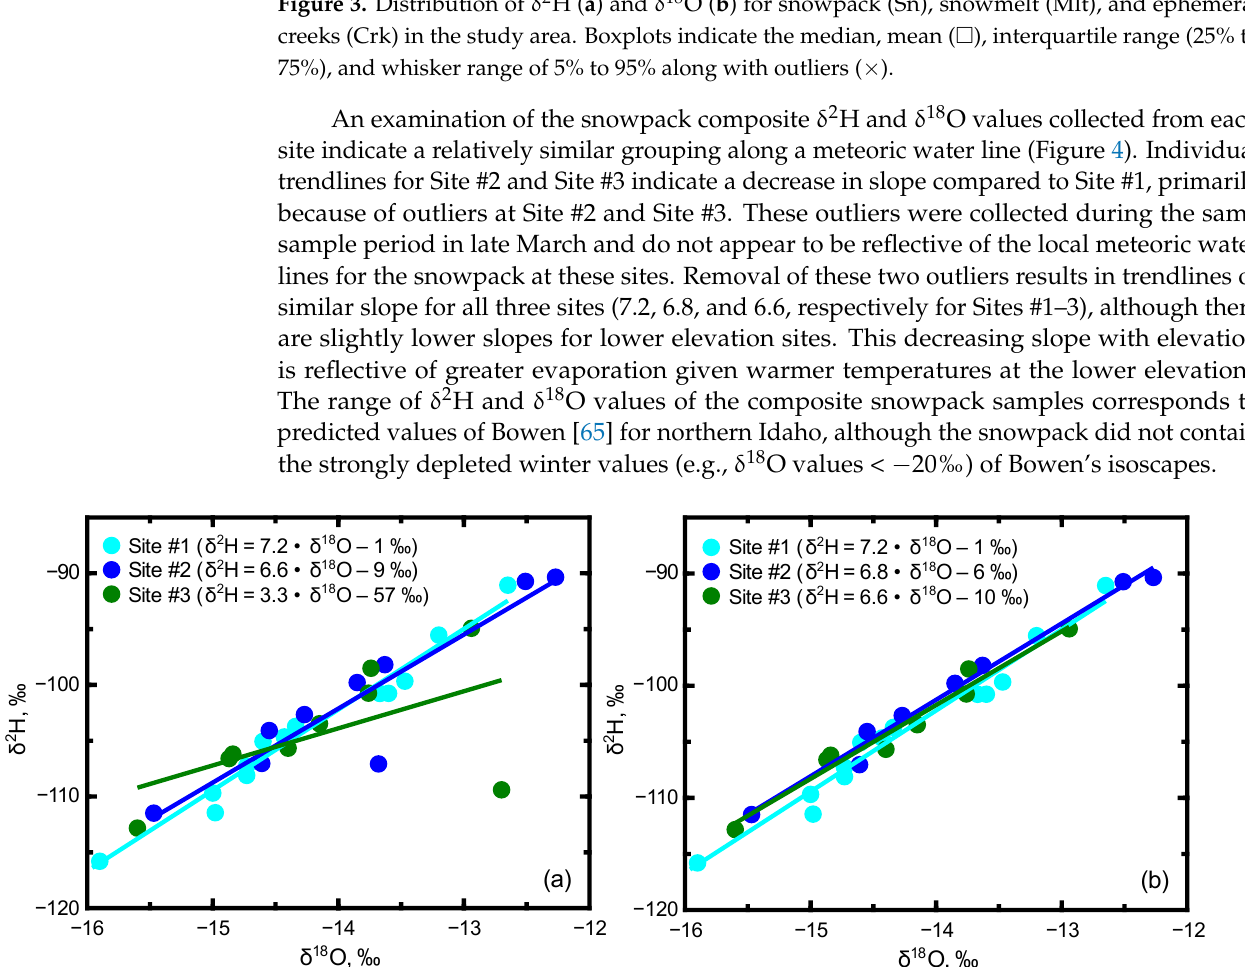
Figure 4. Linear regression trendlines (meteoric water lines) of δ 2 H and δ 18 O for snowpack composite samples collected at the three study sites. Outliers shown in ( a ) were removed to produce ( b